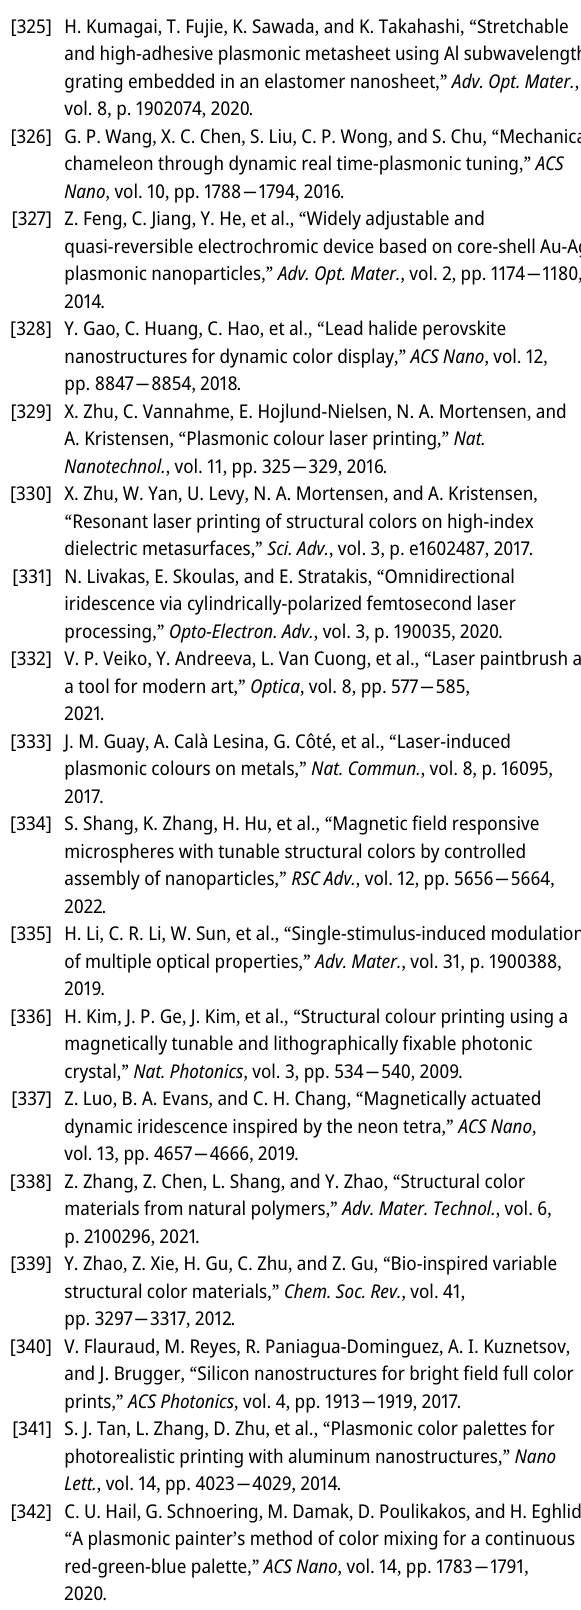
— 1080 D. Wang et al.: Structural color generation: from thin films to optical